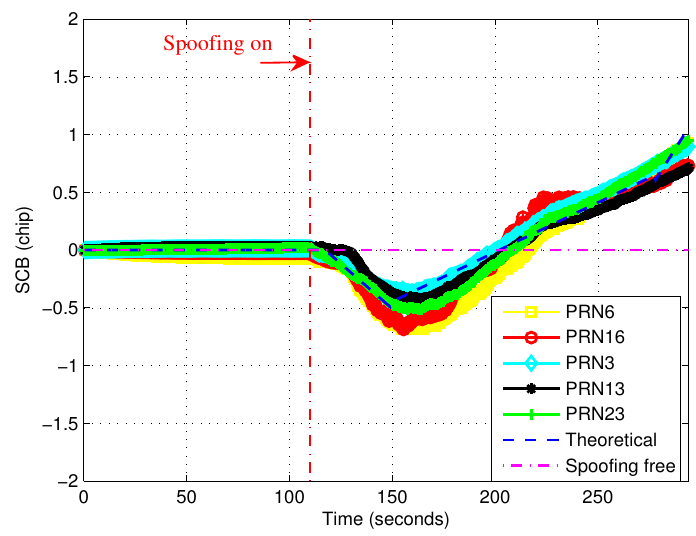
Figure 4. Comparisons between filtered experimental and theoretical SCB curves.